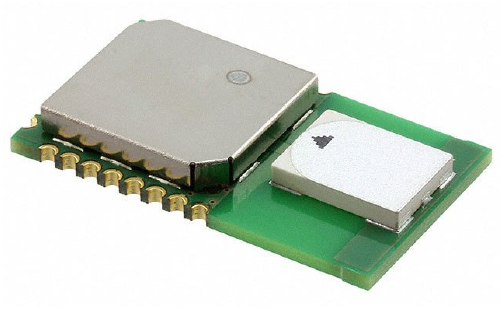
Figure 3. Ultra wideband (UWB) module: Decawave Sensor